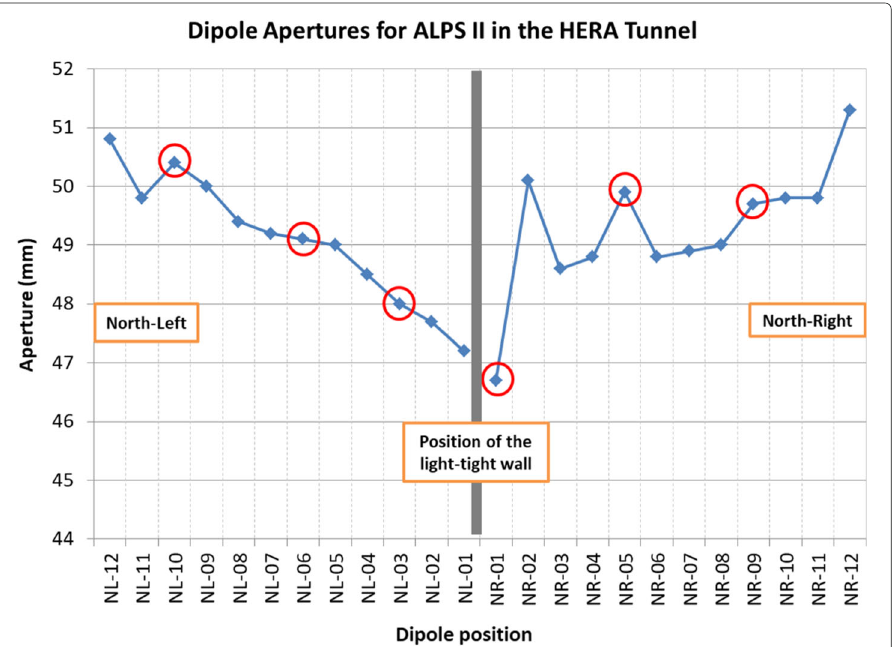
Fig. 21 Horizontal apertures of the dipoles installed in the HERA tunnel. Large apertures are at the outer ends of the magnet strings, smaller apertures close to the middle of the experimental setup. Near the ends of the strings for ALPS II, magnets with large quench currents ( > 6400 A) were selected, to compensate for potential additional heat loads from the neighboring boxes or the cryogenic bypass in the middle of the experimental setup. The positions of dipoles with a pumping port are marked by red circles. The vertical bar in the middle of the experiment indicates the position of the light tight wall